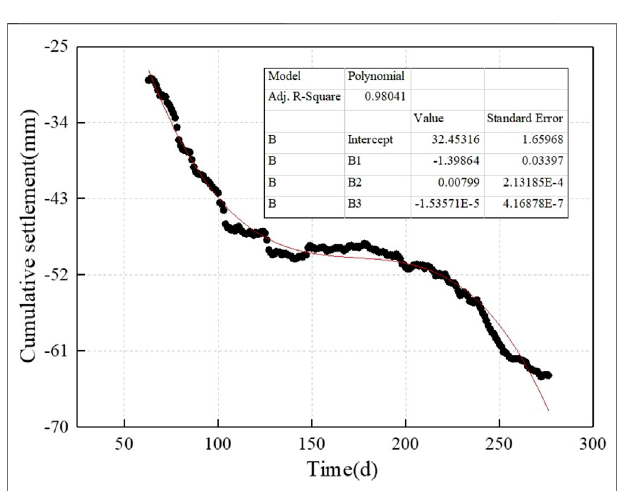
TABLE 7 | The monitoring values of a measuring point in Fushansuo Station.